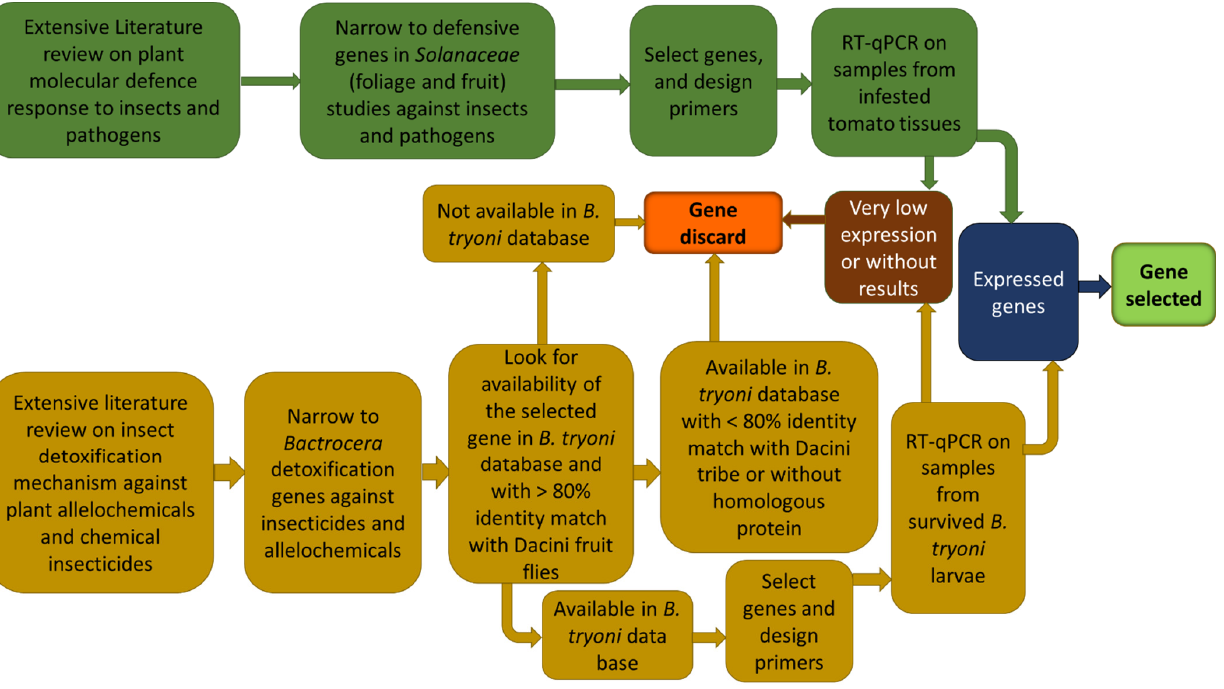
Figure 1. Schematic representation of the workflow used in the present study to choose inducible defence-related genes in tomato fruit and detoxification-related genes in Bactrocera tryoni (from Roohigohar et al., 2021).